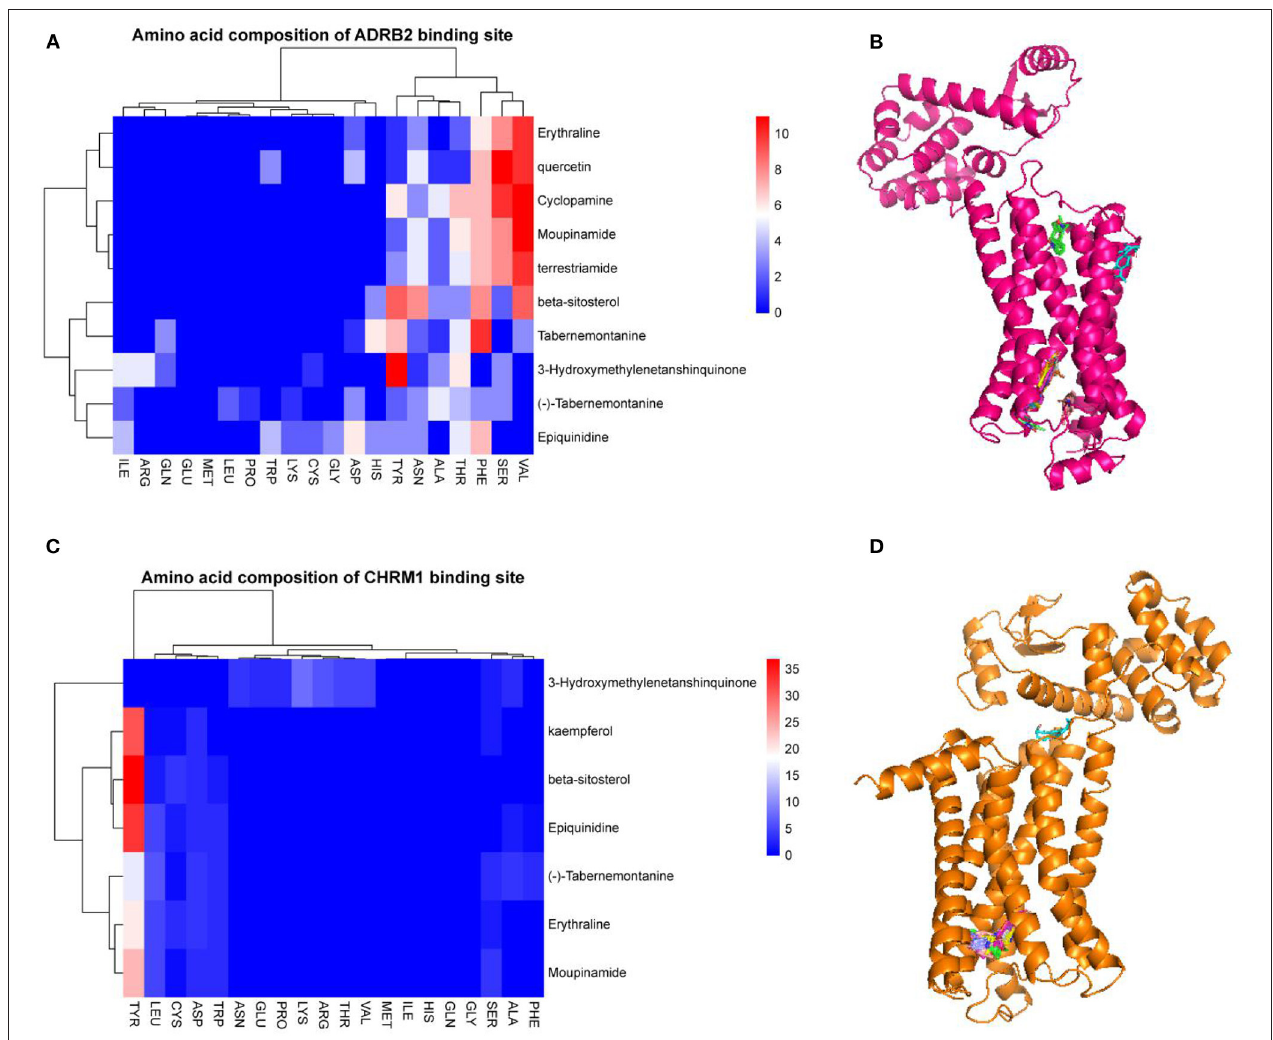
FIGURE 4 | Visualization of molecular docking validation of ADRB2 and CHRM1. Amino acid composition of ADRB2 binding site (A) ; Bulk molecular docking map of ADRB2 (B) ; Amino acid composition of CHRM1 binding site (C) ; Bulk molecular docking map of CHRM1 (D)